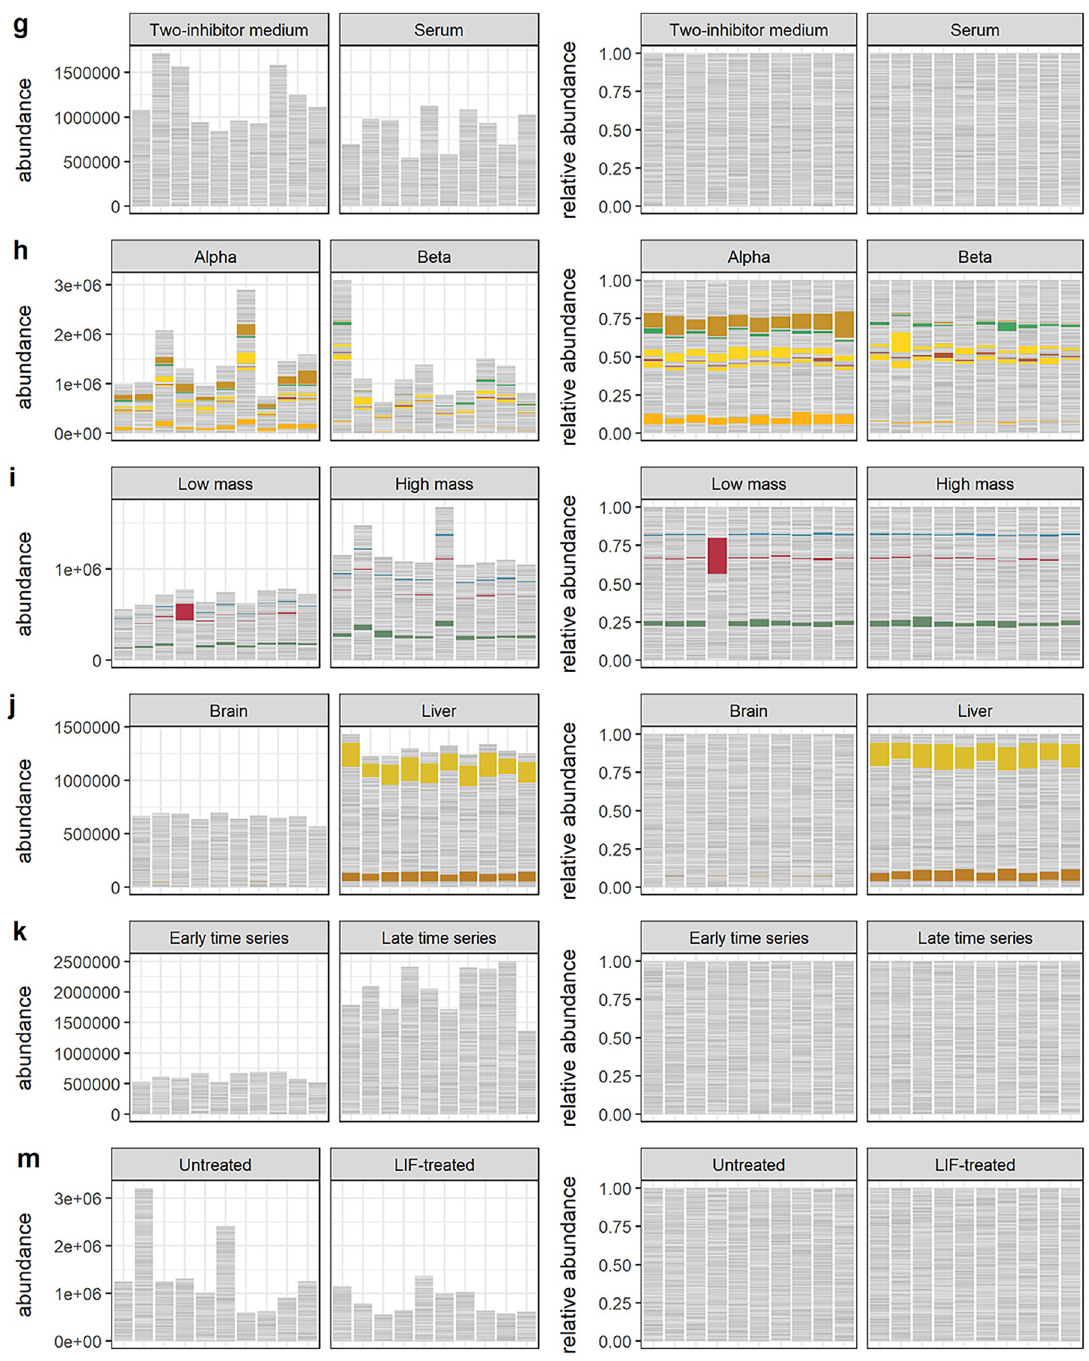
Fig 4. Visual summaries of real data sets 7–12. Visual summaries of nominal abundances (left panels) and relative abundances (right panels) for g) Gru¨n et al. h) Muraro et al. i) Kimmerling et al. j) Yu et al. k) Owens et al. m) Klein et al. Features (genes or bacterial sequence variants) with at least 1% relative abundance across all samples are colored; all other features are